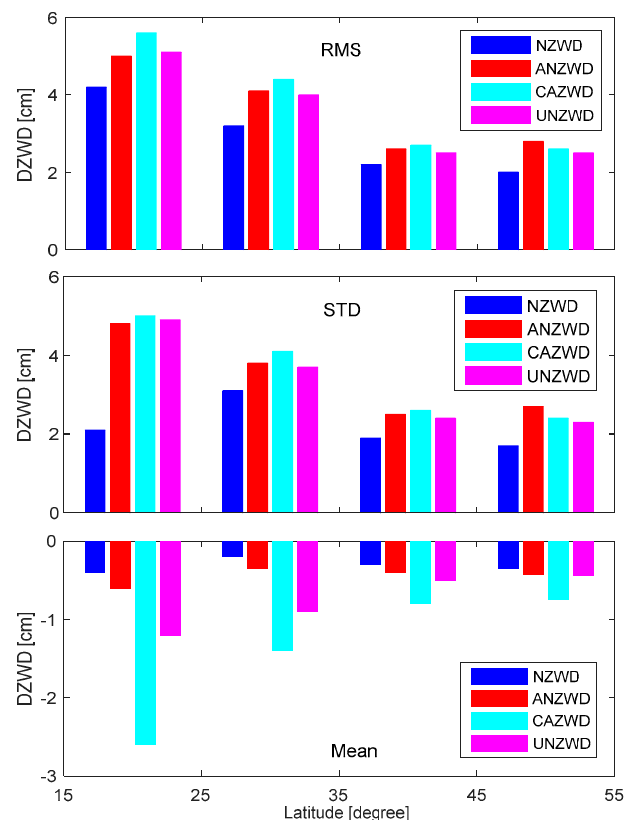
Figure 5. The accuracy of the three ZWD models at different latitudes relative to the radiosonde profiles.